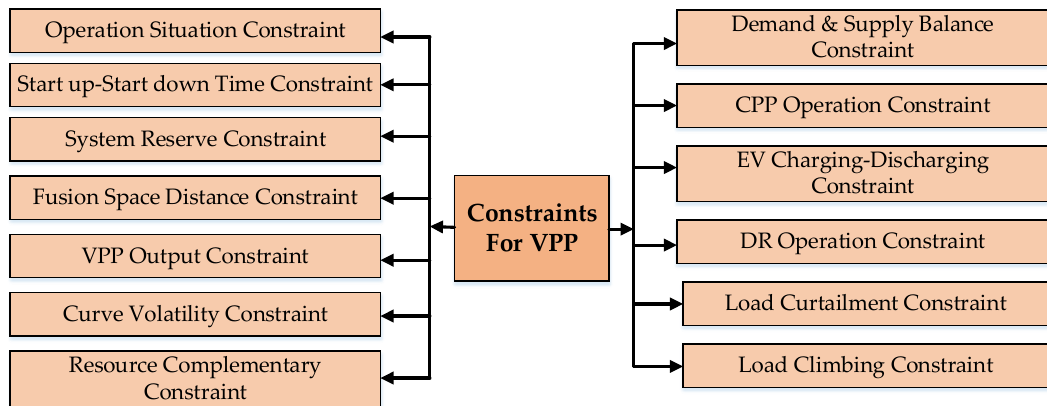
Figure 6. A representation of different constraints for virtual power plant optimization. (Note: VPP- virtual power plant; CPP-conventional power plant; EV-electric vehicle; DR; demand response).